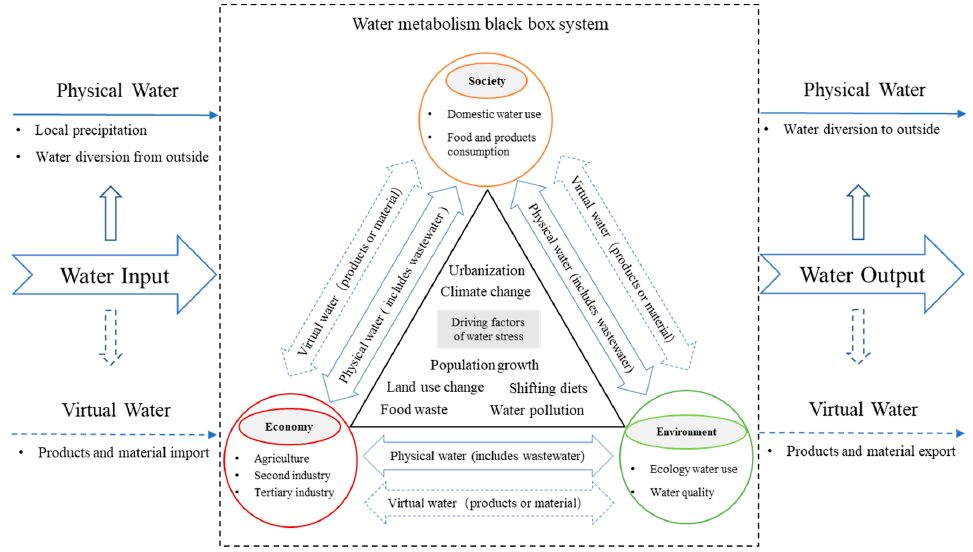
Figure 10. The metabolic process of regional physical and virtual water [77] .